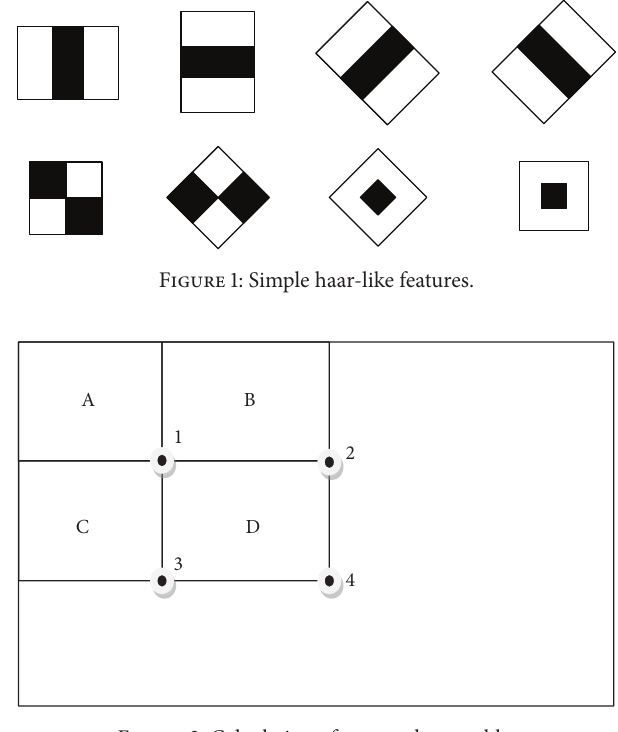
Figure 2: Calculation of summed area